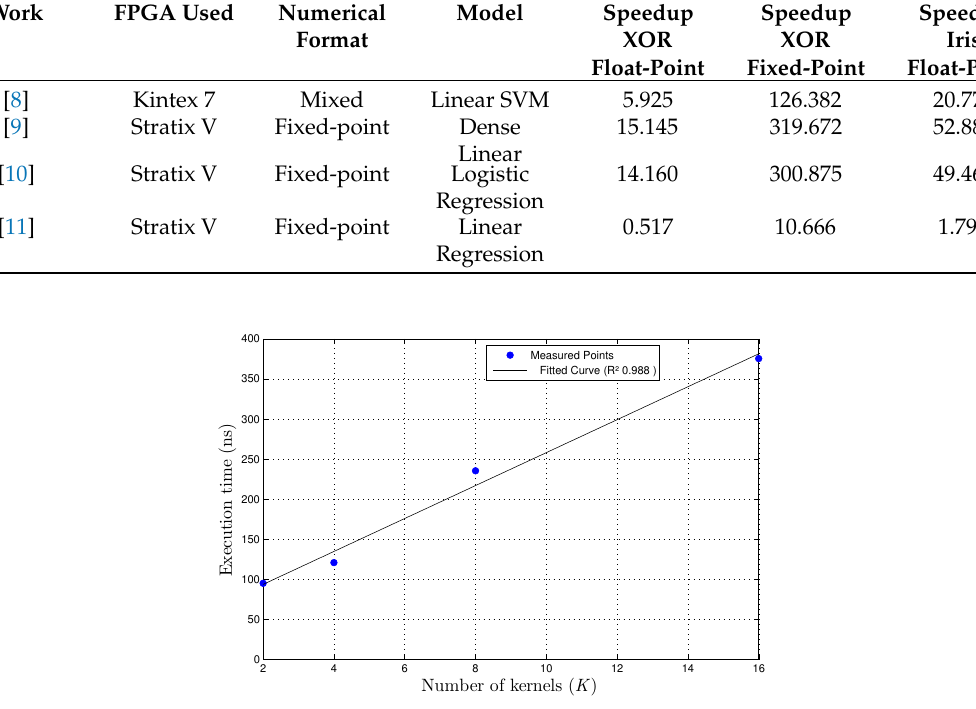
Figure 12. Linear regression curve for execution time per sample for varing numbers of kernels k , XOR dataset floating-point precision.